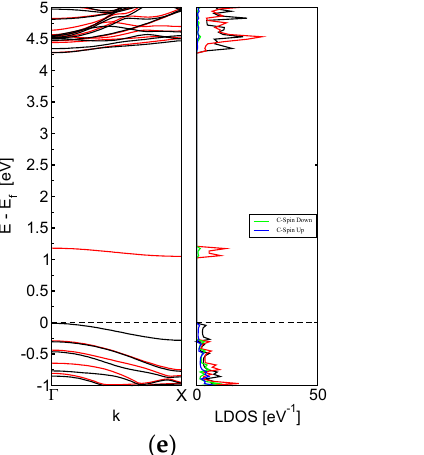
Figure 4. Electronic properties after the adsorption process of NO 2 for ( a ) E_M ‐ BNNR and ( b ) C_M ‐ BNNR, NH 3 for ( c ) E_M ‐ BNNR and ( d ) C_M ‐ BNNR, and NH 4 for ( e ) E_M ‐ BNNR and ( f ) C_M ‐ BNNR. Graphs represent band structure with the corresponding local density of states.